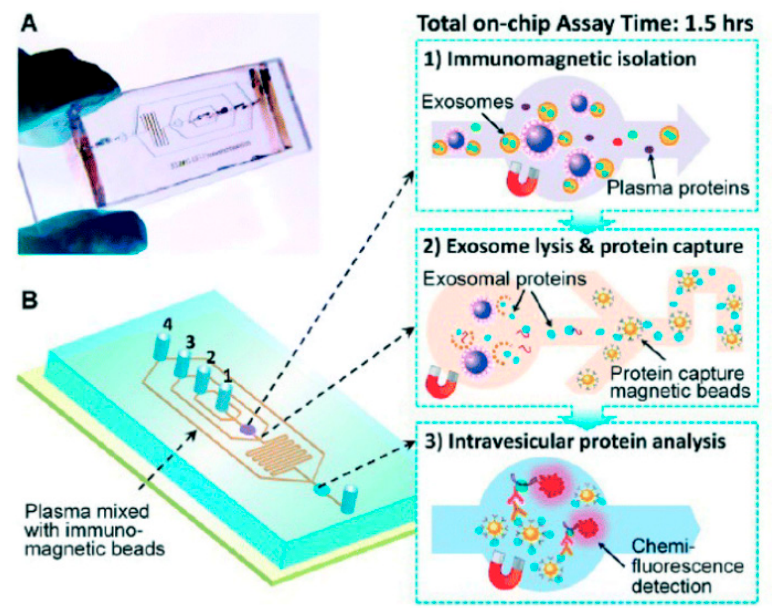
Figure 4. Microfluidic device for exosome capture and intravesicular protein detection. ( A ). Image of the microfluidic device. ( B ). Workflow of on-chip exosome analysis. 1. Isolation of exosome-captured magnetic beads from plasma. 2. Exosome lysis and magnetic bead-based protein capture. 3. Protein analysis by chemical fluorescence detection. Reprinted with permission from He et al. [30]. Copyright 2014 Royal Society of Chemistry, 2014.